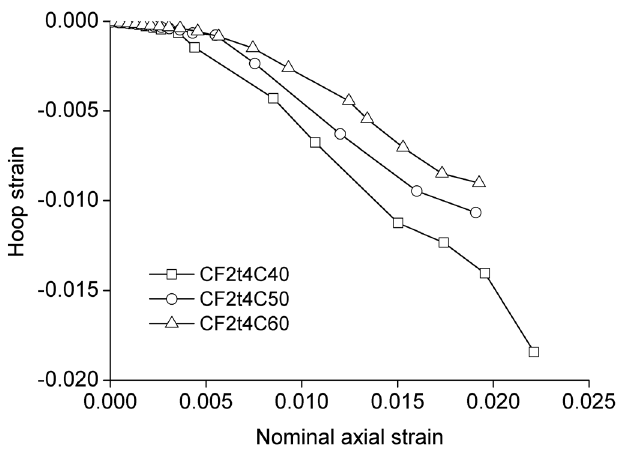
Figure 9. Nominal axial strain vs. hoop strain in terms of concrete